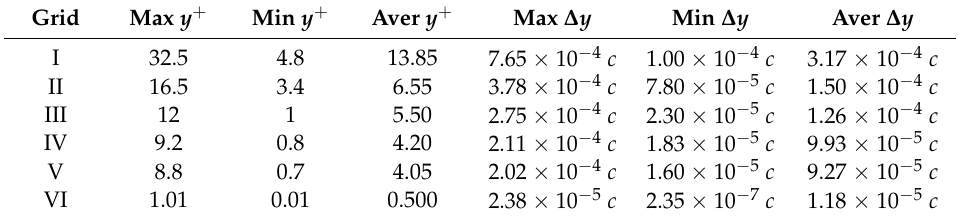
Table 3. Estimated size of the first cell height near the wall as a fraction of airfoil chord length.